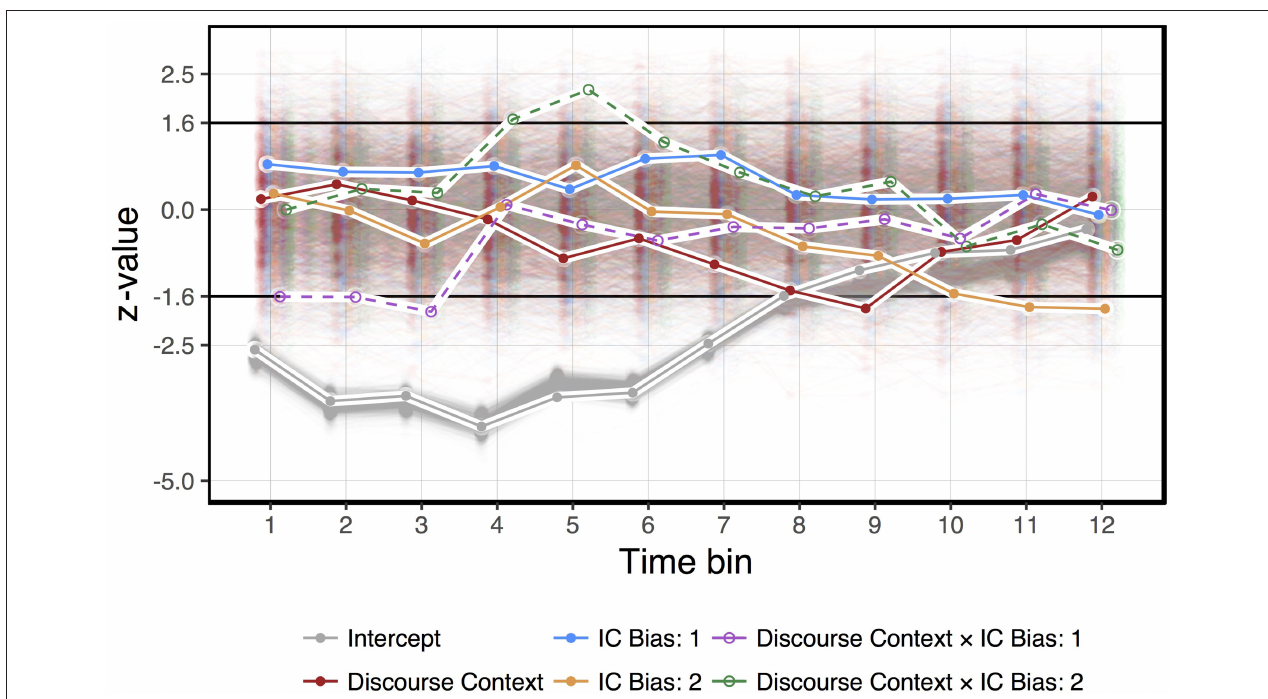
FIGURE 5 | Experiment 2: the z -values for all predictors included in the model across the twelve 100ms time bins from the onset of the connective, superimposed onto the empirical distributions of z -values for the permuted predictors in 1,000 simulations.